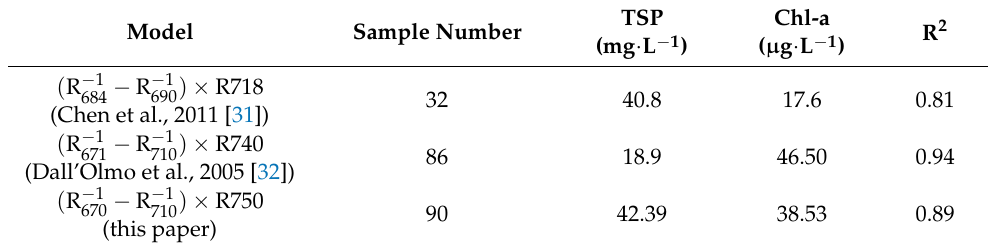
Table 9. Comparison of retrieval results for three-band Chl-a models.